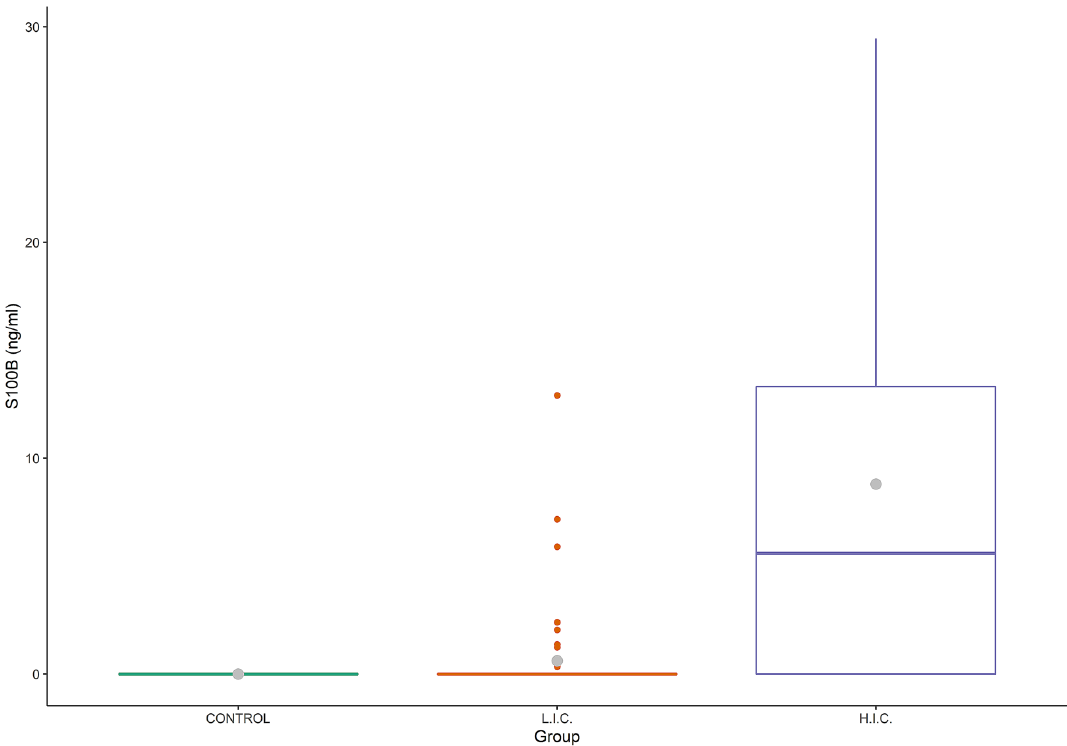
Figure 1. Detection of S100B in Covid patients and controls. Box plot showing the distribution of S100B in Covid (n = 74) patients with different clinical severity of disease. Also data from controls (n = 5 healthy individuals: negative for SARS-CoV-2 detection by PCR and negative by serologic test) are included. Grey dot: mean value, Line: median value; HIC: High Intensity Care; LIC: Low Intensity